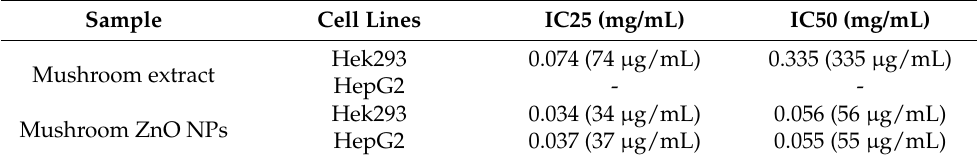
Table 2. The extrapolated IC25 and IC50 concentrations for HepG2 and Hek293 cells. Sample Cell